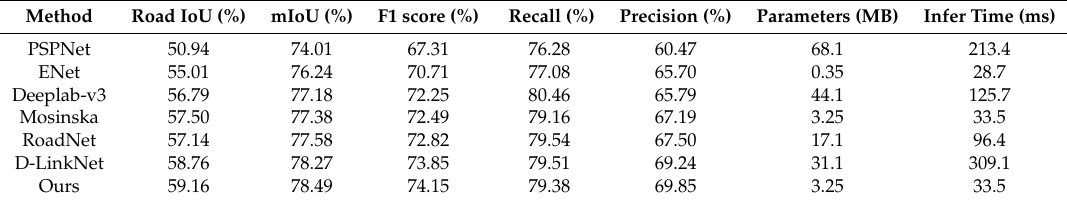
Table 2. Performance comparisons of different methods on the Massachusetts Dataset in terms of Road IoU, mIoU, F1 score, recall, precision, parameters, and Infer Time. The best results are shown in bold. Method